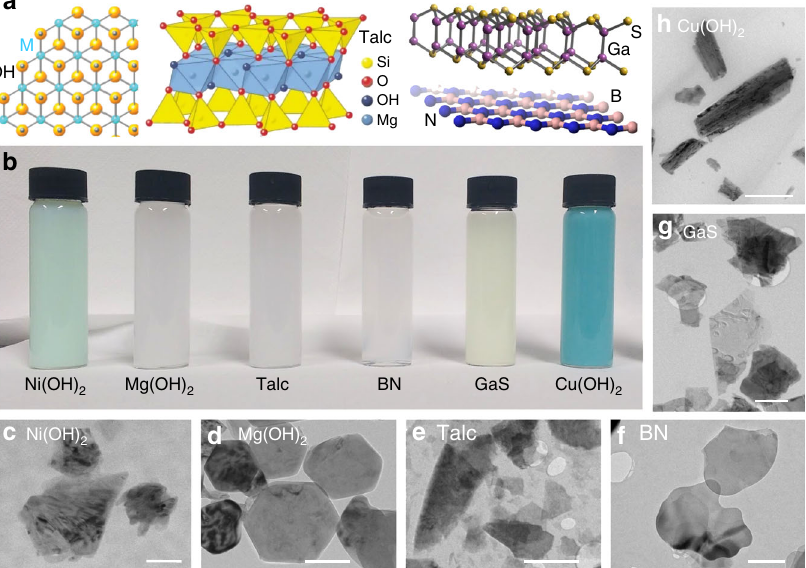
Fig. 1 Exfoliation of insulating 2D materials. a Structure of materials used. Left-right: metal hydroxides (M(OH) 2 where M = Ni, Mg or Cu in this work), talc (Mg 3 Si 4 O 10 (OH) 2 ), GaS and BN. b Photograph of dispersions of all six materials. In each case, these are very large (XL), size-selected nanosheets which show strong scattering. c – h Representative TEM images of few-layer nanosheets of each type (in each case extracted from XL fractions). In panels ( c , d ), the scale bar is 200 nm while in ( e – h ), it is 500